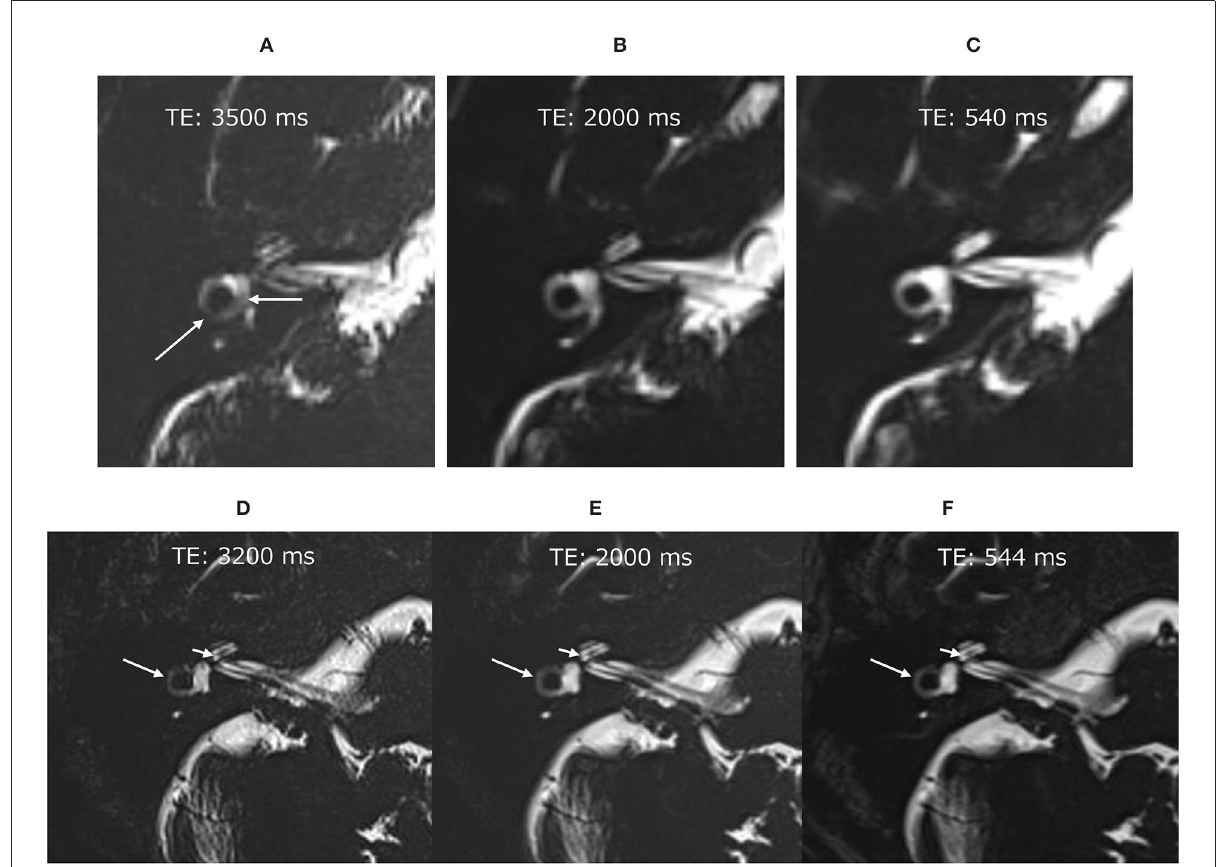
FIGURE2 Pilot scans in volunteers without administration of the 17 O-labeled water tracer. In the image with an echo time (TE) of 3,500ms (A) , the vestibular signal was not uniform, and the lateral semicircular canal was not continuous (arrows). Note that these structures were visualized clearly in the images with a TE of 2,000ms (B) and TE of 540ms (C) . Pilot scans in another volunteer without 17 O-labeled water tracer administration. Although the image with a TE of 3,200ms was slightly noisy (D) , the anatomy of the labyrinth could be seen clearly. The signal for the vestibule was more uniform in the image with a TE of 3,200ms (D) than in that with a TE of 3,500ms (A) . For example, the osseous spiral lamina of the cochlea (short arrow) and the lateral semicircular canal (arrow) could be identified in all images of this volunteer (D–F)